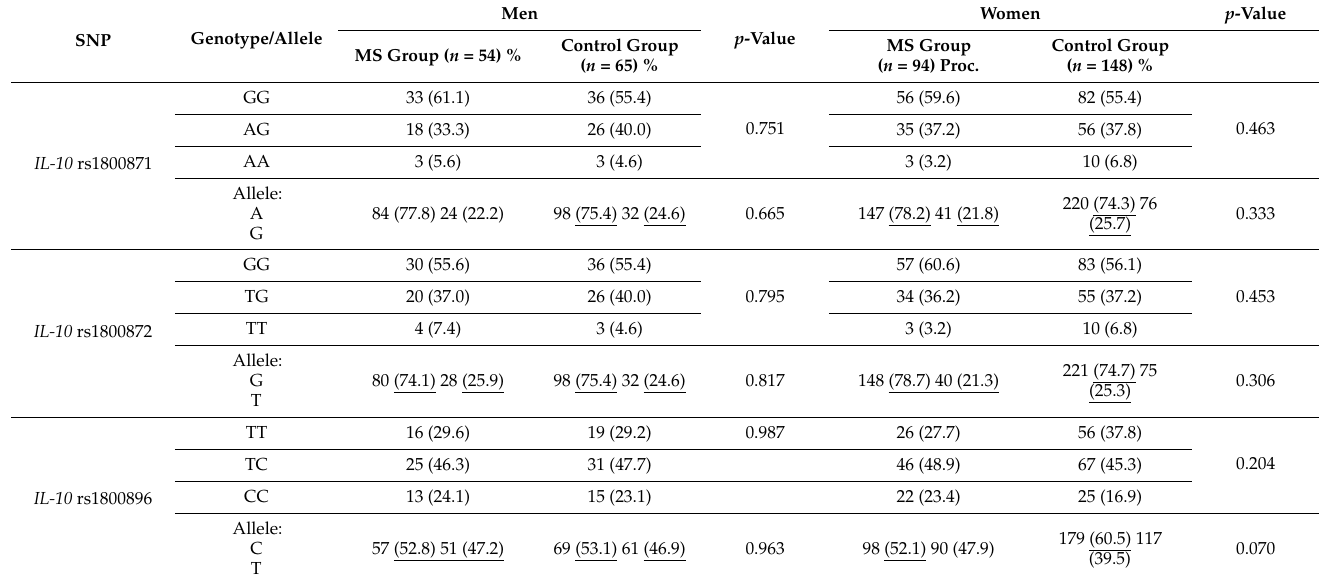
Table 4. IL-10 rs1800871, rs1800872, and rs1800896 genotype and allele frequencies in MS patients and controls by